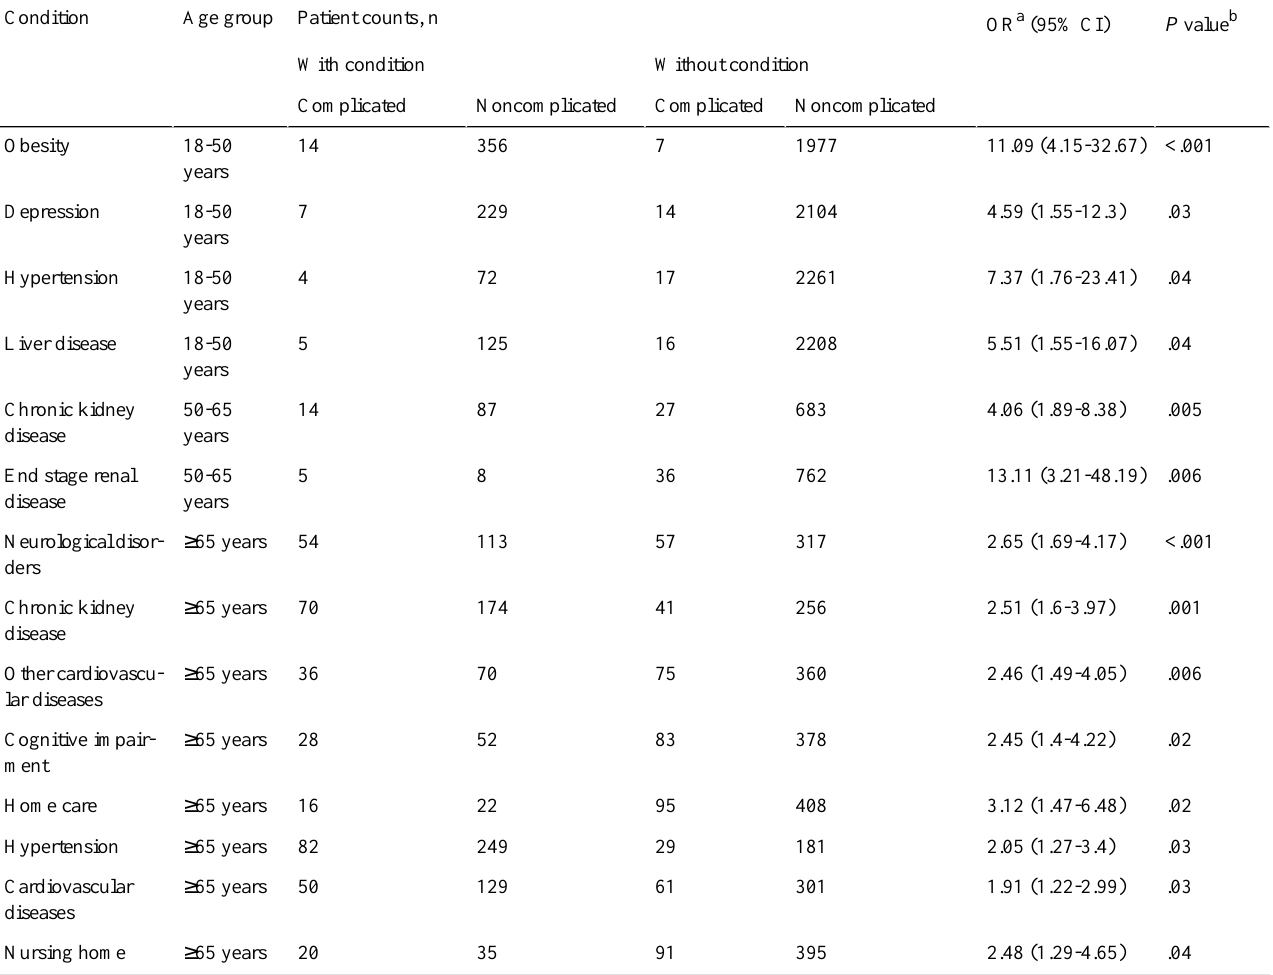
Table 3. Most statistically significant conditions associated with increased risk of coronavirus disease (COVID-19) complications in age-stratified patient